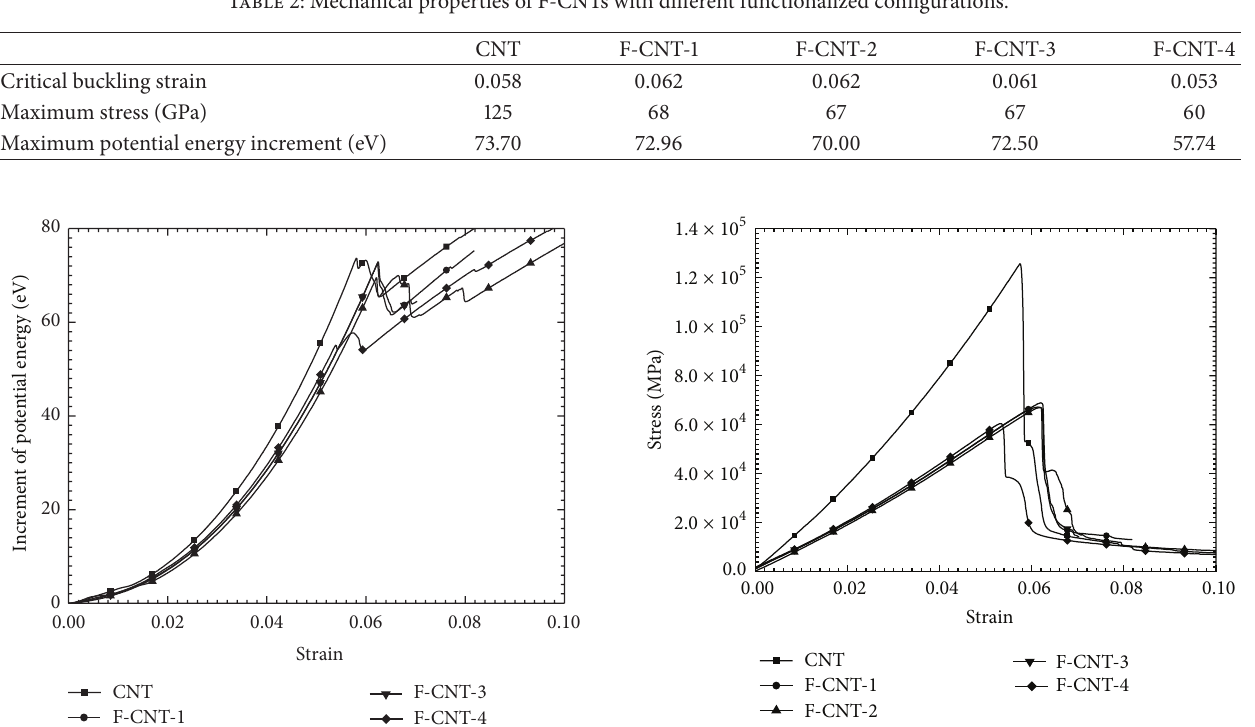
Table 2: Mechanical properties of F-CNTs with different functionalized configurations.